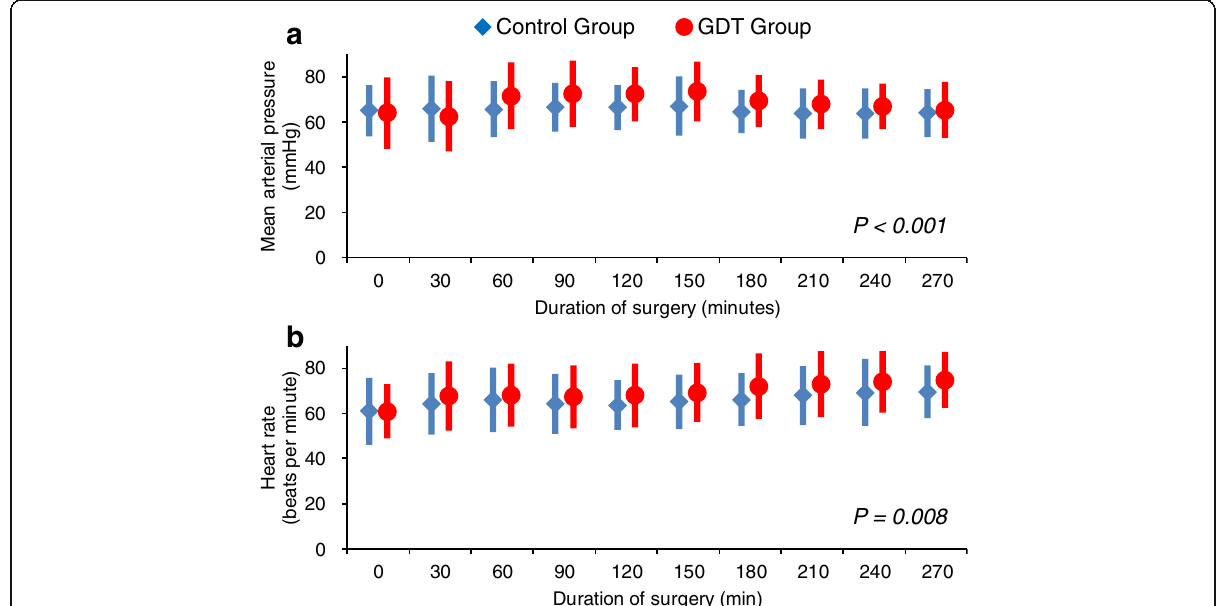
Fig. 3 Mean arterial pressure and heart rate during surgery. Filled diamonds and circles indicate means, and error bars indicate standard deviations. a Mean arterial pressure. b Heart rate. P values were calculated using repeated measures